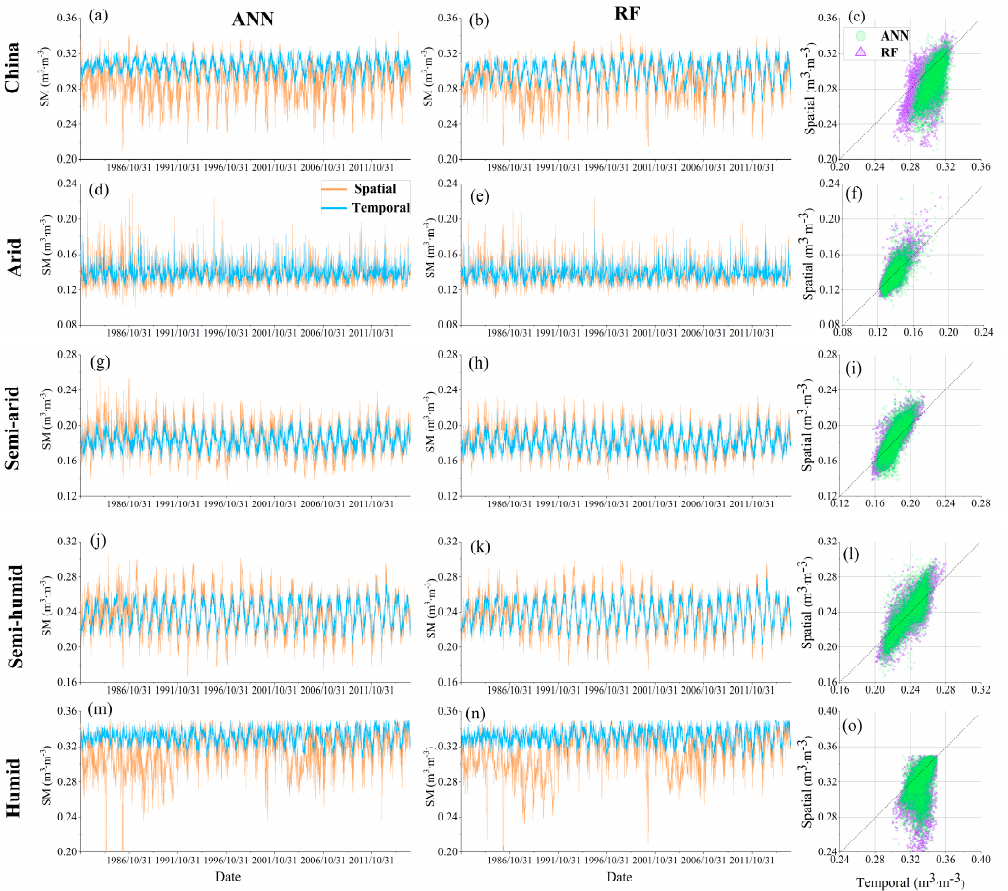
Figure 5. Comparison of reconstructed soil moisture series in the spatial and temporal domains by using the ANN and RF models over China and in four climate zones. ( a , d , g , j , m ) The comparison of average values of reconstructed soil moisture series obtained in the spatial and temporal domains by using the ANN model. ( b , e , h , k , n ) The comparison of average values of reconstructed soil moisture series obtained in the spatial and temporal domains by using the RF model. ( c , f , i , l , o ) Scatter plot of all spatial values and temporal values in the area.